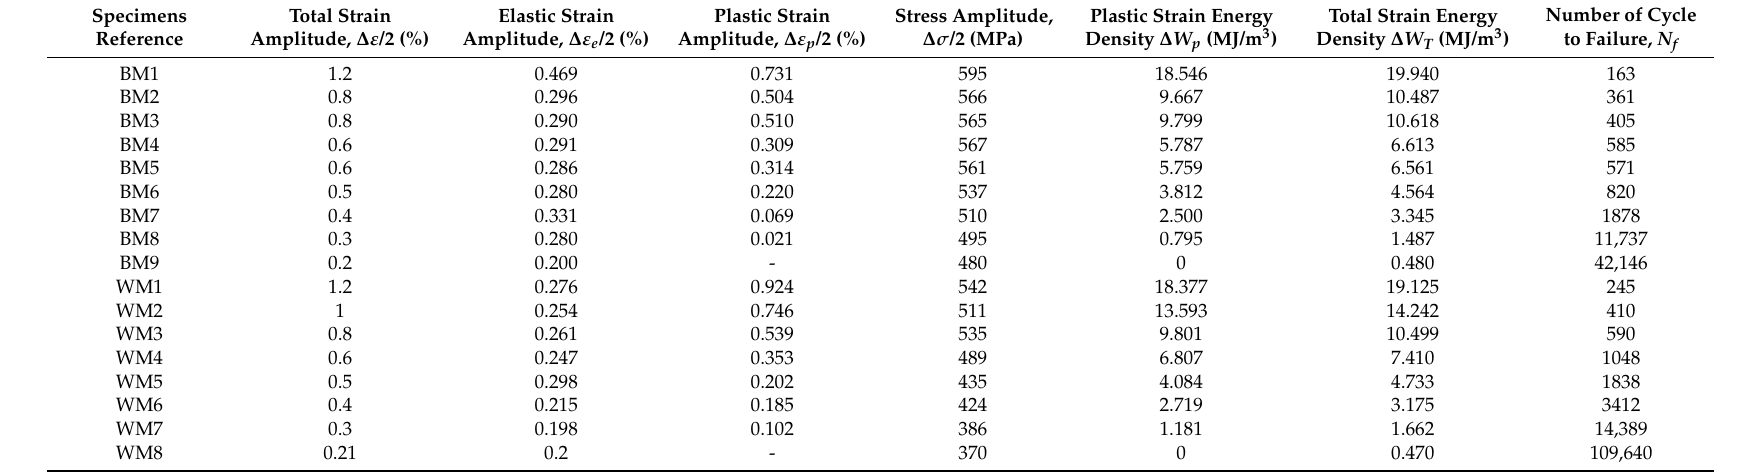
Table 4. Summary of LCF fatigue tests